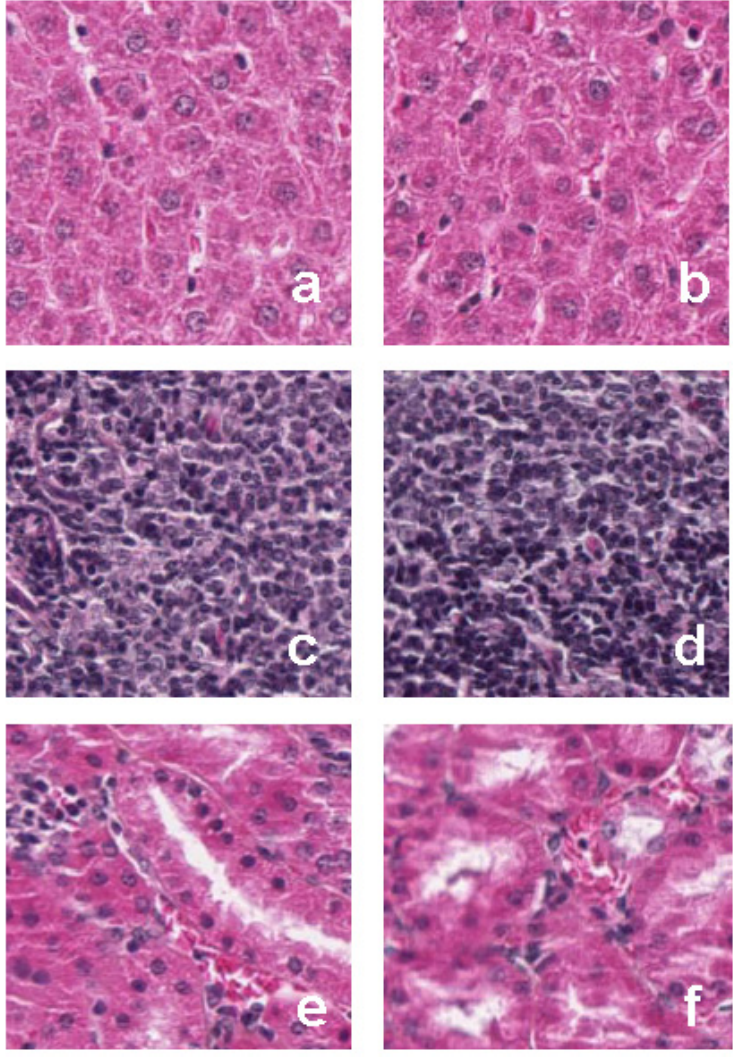
Figure 9. Histological analysis of tissues from control or Lavandula pedunculata (LP) treated rats. Rats were given LP or water every day for 4 weeks by gavage. Liver, spleen, and kidney slices were analyzed from control ( a , c , e , respectively) or LP-treated rats ( b , d , f , respectively). No cellular modifications were observed in the rats receiving LP in comparison with the